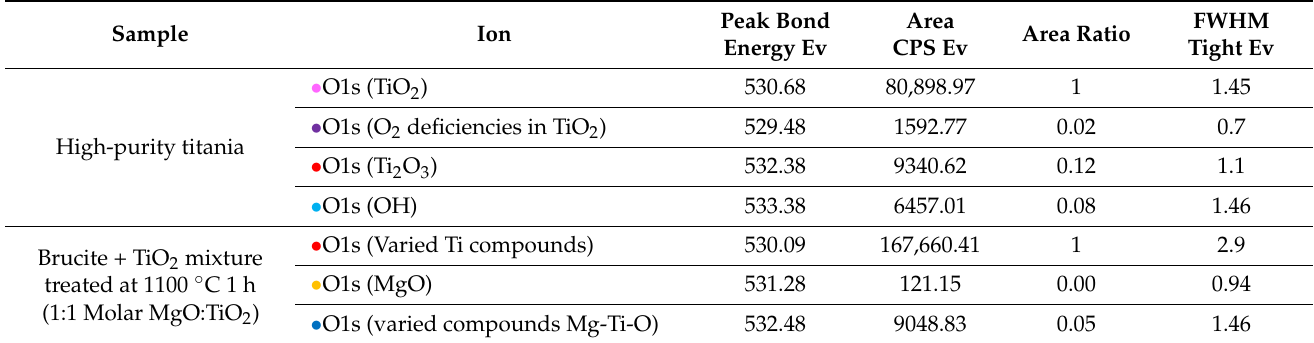
Table 6. Details of the data obtained from XPS analysis of O1s for samples of pure titania and mixture of brucite and titania, with the latter heat treated at 1100 ◦ C for 1